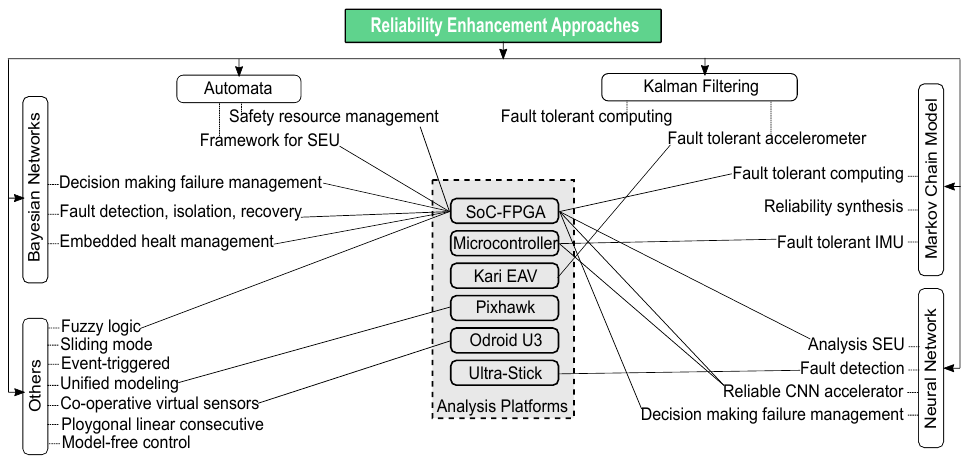
Figure 4. UAV computing platform reliability enhancement